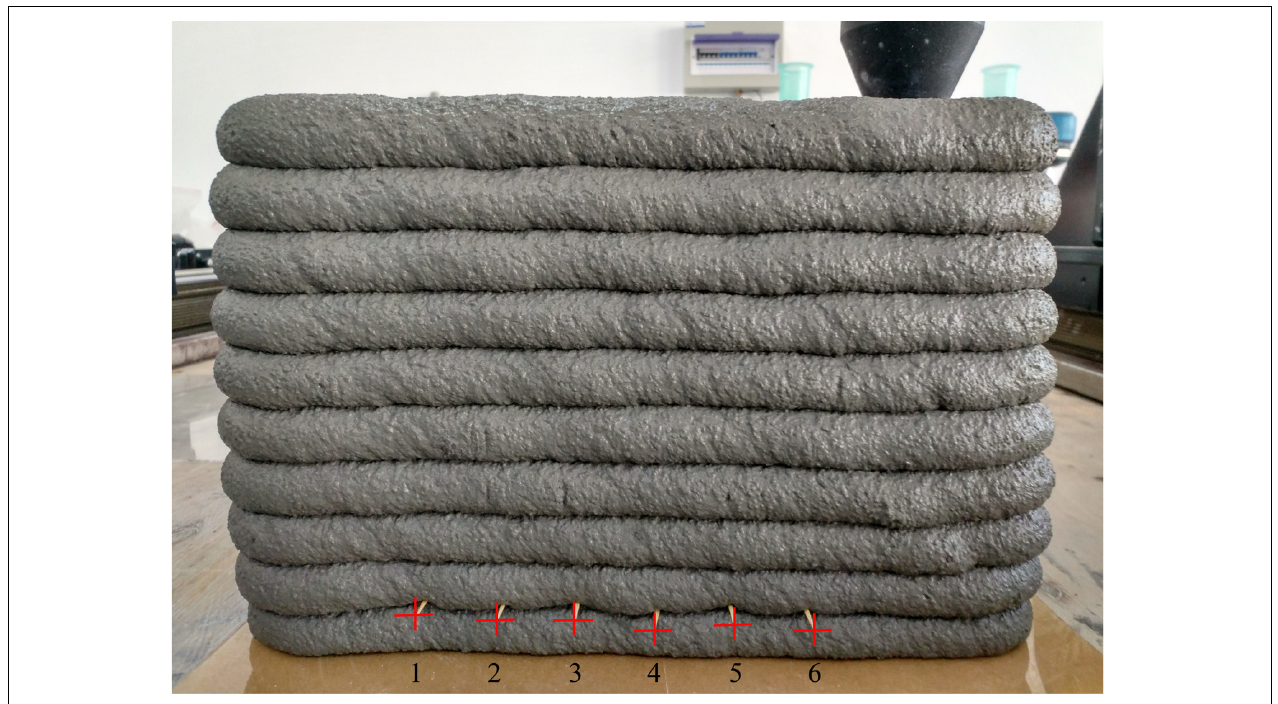
FIGURE 4 | Deformation under